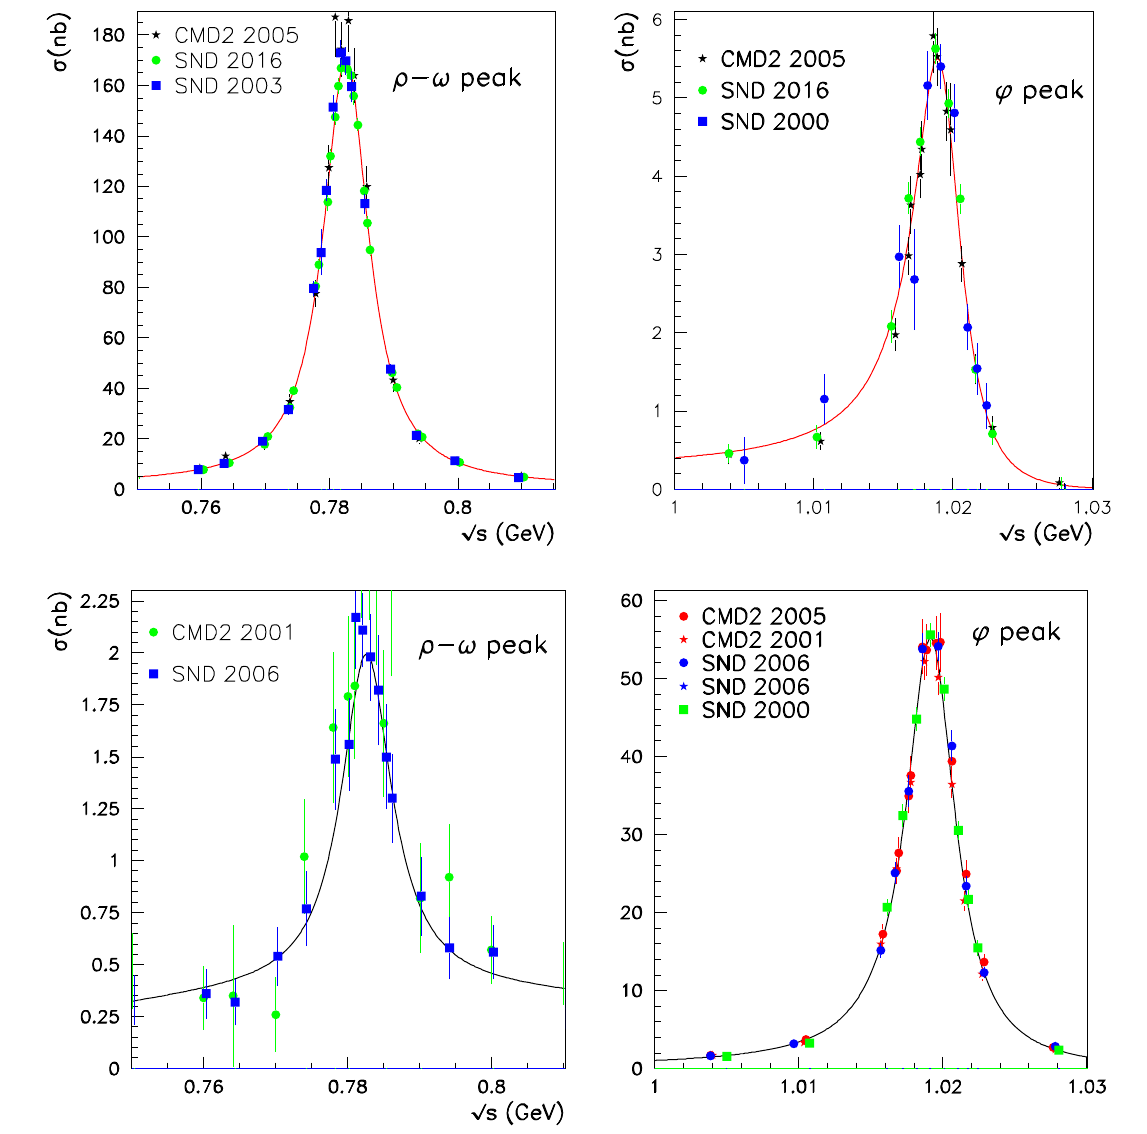
Fig. 4 BHLS 2 fit to the (π 0 /η)γ spectra, the RS solution: top panels show the case for the π 0 γ spectra in the ω and φ regions, the bottom